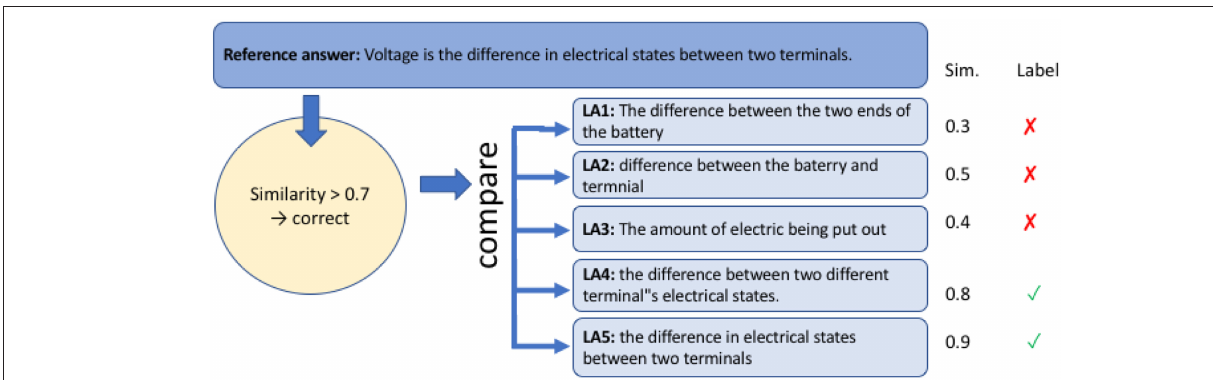
FIGURE 4 | Schematic overview of similarity-based scoring.